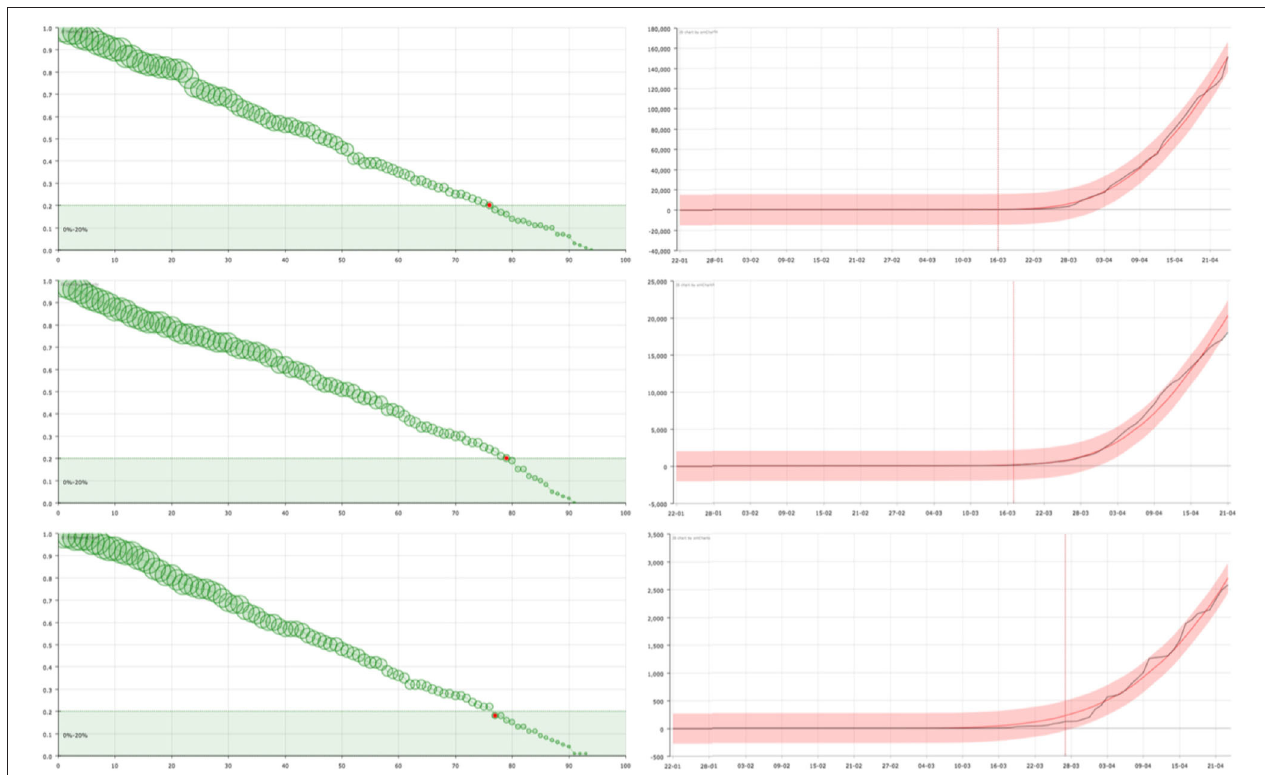
FIGURE 2 | On the right, curve fitting of the sum of the accumulated number of recovered and dead people in USA (top) , United Kingdom (center) , and Sweden X ). The x-axis represent the date and the y-axis represents the number of cases. Vertical (bottom) : black line is the real value ( X ) and red line is the approximation ( b line signs the 100 cases. On the left, the corresponding survival curve of the virus S . The red point signs the number of days after which a standard individual has a probability of staying in the group of infected people smaller than 0.2. This value has been arbitrarily set as an aid to the visualization of the decreasing of the curve. The size of the balls is proportional to their value at the